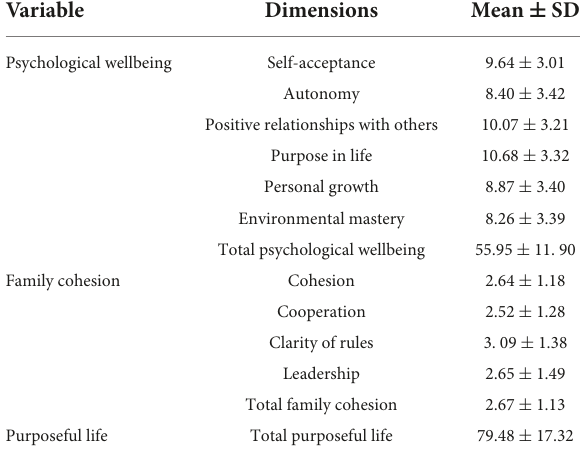
TABLE 2 Mean scores of variables and their dimensions in male